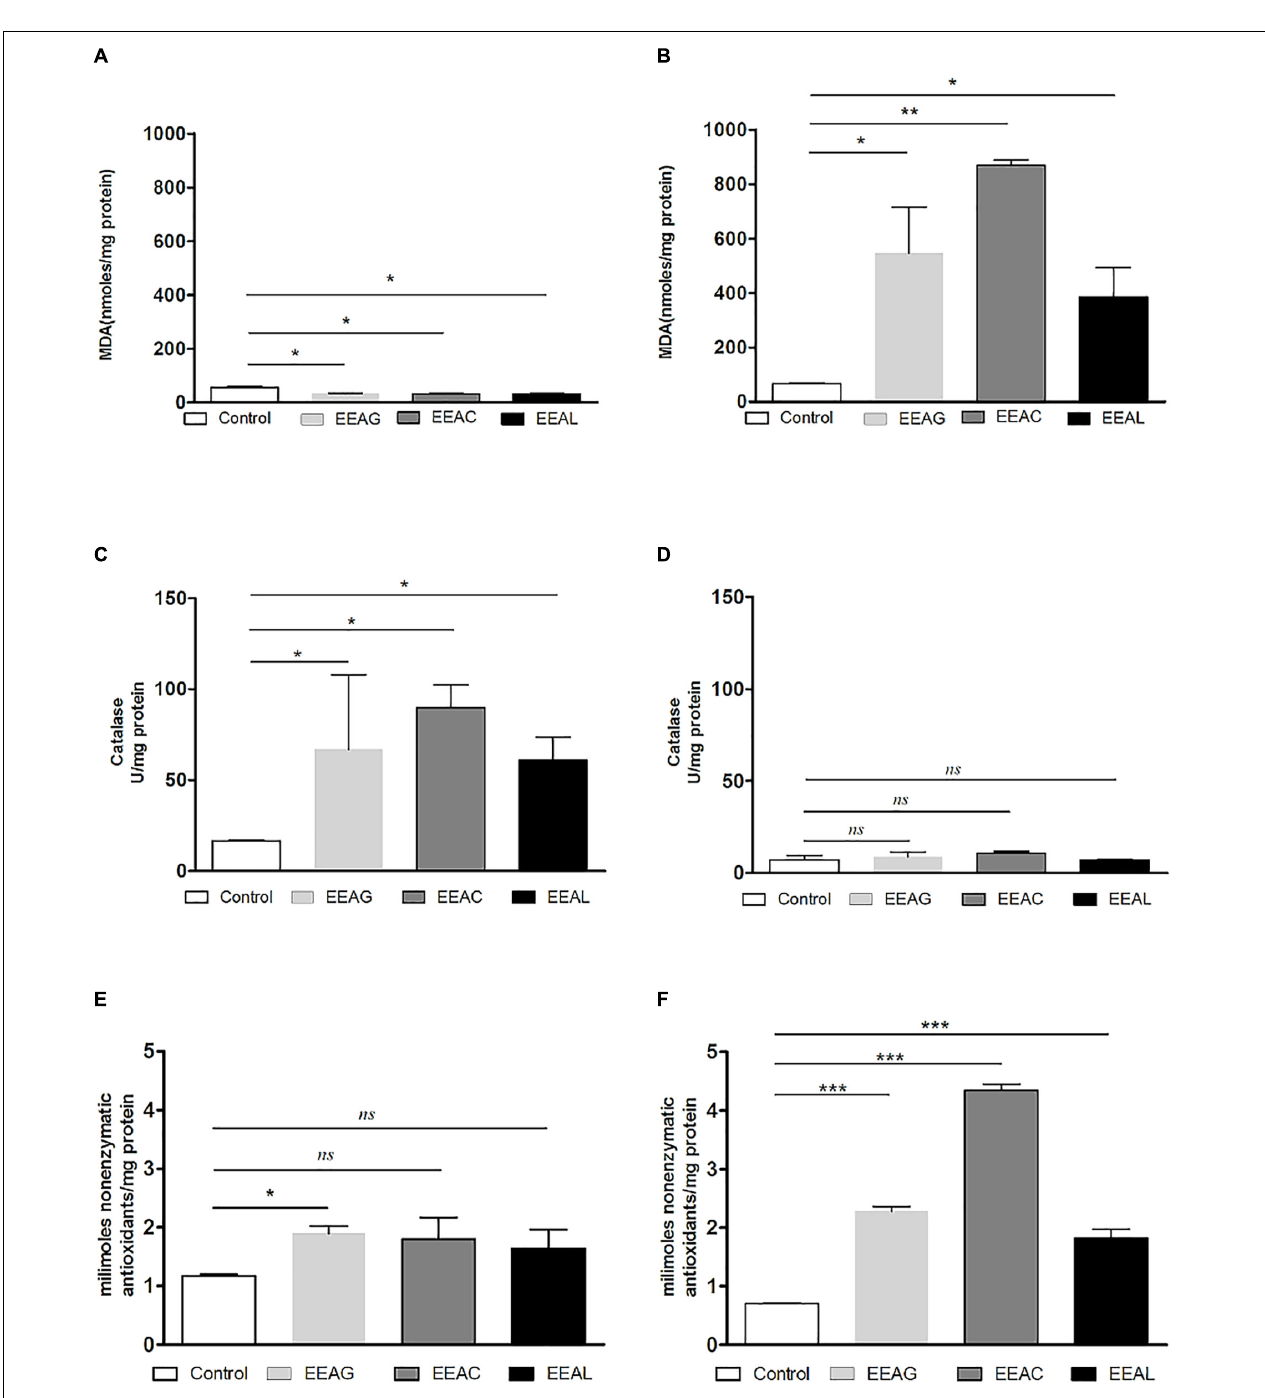
FIGURE 8 | Effects of Ajuga sp. extracts on the oxidative stress generated by B16.F10 melanoma cells. (A,B) MDA concentration after (A) : IC 20 EEAG, IC 50 EEAC, and IC 50 EEAL treatment and (B) : IC 40 EEAG, IC 80 EEAC, and IC 80 EEAL treatment. (C,D) Catalytic activity of catalase after (C) IC 20 EEAG, IC 50 EEAC, and IC 50 EEAL treatment and (D) : IC 40 EEAG, IC 80 EEAC, and IC 80 EEAL treatment. (E,F) Total non-enzymatic antioxidant system levels in the cell lysates obtained from standard culture of B16.F10 murine melanoma cells after 24 h of incubation with (E) : IC 20 EEAG, IC 50 EEAC, and IC 50 EEAL treatment and (B) : IC 40 EEAG, IC 80 EEAC, and IC 80 EEAL treatment. One way ANOVA test with Bonferroni correction for multiple comparisons was performed to analyze the differences between the effects of the treatments applied on MDA and non-enzymatic antioxidant defense systems levels and on catalase activity. Control, untreated B16.F10 cells; IC 40 or IC 20 EEAG, cells incubated with 650 µ g/mL or 260 µ g/mL A. genevensis ethanolic extract; IC 80 or IC 50 EEAC, cells incubated with 650 µ g/mL or 406.7 µ g/mL A. chamaepitys ethanolic extract; IC 80 or IC 50 EEAL, cells incubated with 325 µ g/mL or 236.8 µ g/mL A. laxmannii ethanolic extract. (ns, P > 0.05; ∗ P < 0.05; ∗∗ P < 0.01; ∗∗∗ P <